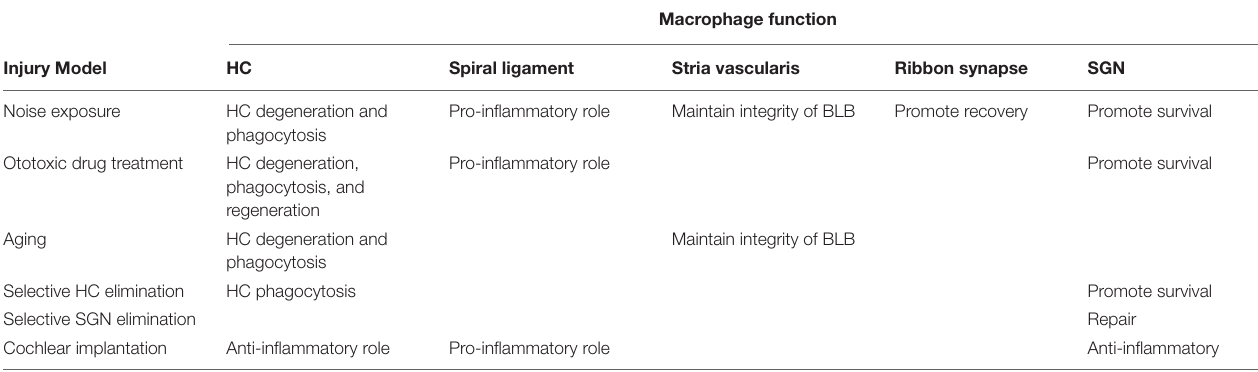
FIGURE 1 | The distribution of macrophages in the basilar membrane, spiral ligament, stria vascularis, OSL, and spiral ganglion. Macrophages in the basilar membrane are distributed below in the HCs on the scala tympani side. Macrophages in the apical turn show dendritic morphology, those in the middle turn display irregular morphology with short projections, and those in the basal turn transform into amoeboid morphology. Macrophages in the lateral wall contain PVM/Ms of the stria vascularis and macrophages among fibrocytes in the spiral ligament. Macrophages are present around the neural tissue, which is composed of SGN cell bodies and their peripheral nerve fibers inside the OSL as well as the modiolus. Most of the macrophages in the OSL area lie in a direction parallel to the radial fibers. M, macrophages; PVM/M, perivascular macrophage-like melanocyte; RS, ribbon synapse; EC, endothelial cells; PC, pericytes; IHC, inner hair cell; OHC, outer hair cell; OSL, osseous spiral lamina; SGN, spiral ganglion neuron. TABLE 1 | The role of macrophages on the hair cell (HC), spiral ligament, stria vascularis, ribbon synapse, and spiral ganglion neuron (SGN) in different injury